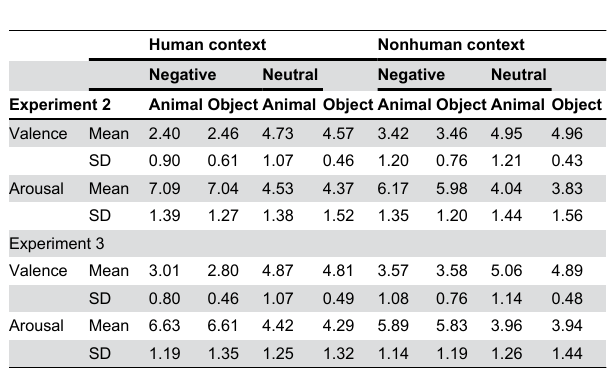
Table 2. Valence and arousal scores in Experiments 2 and